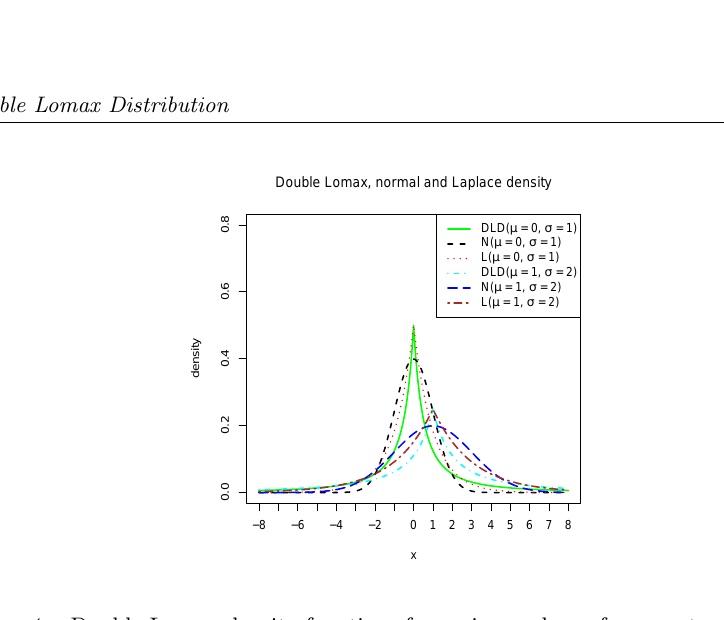
Figure 1 { Double Lomax density functions for various values of